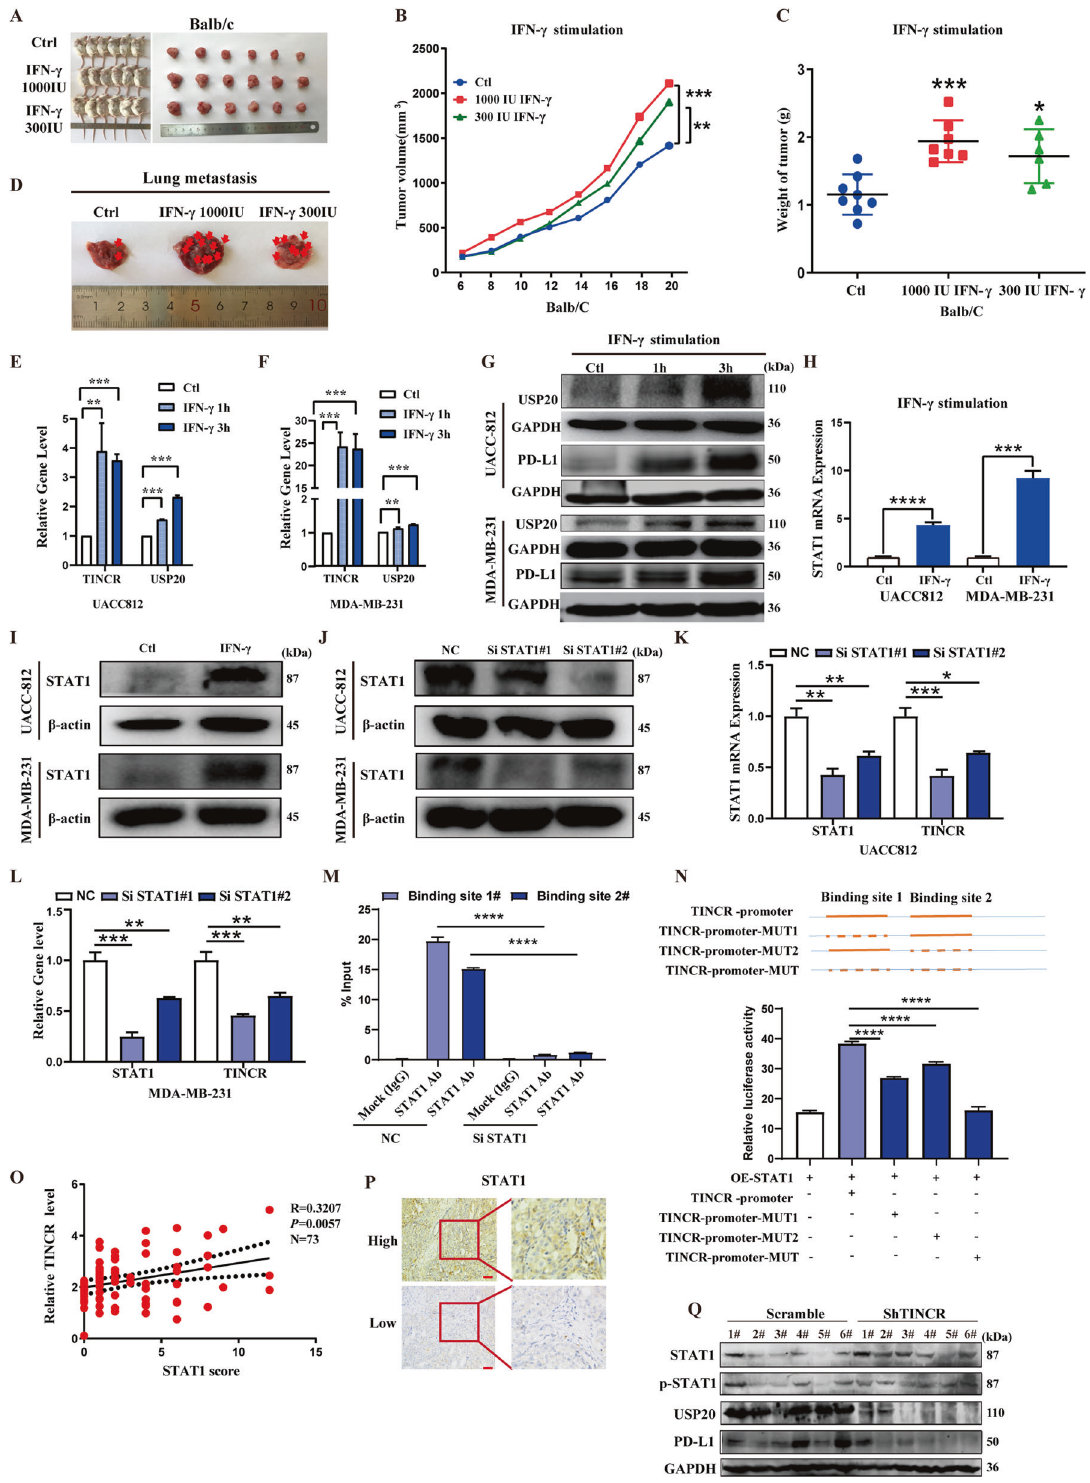
Fig. 6 IFN- γ promotes TINCR expression by upregulating STAT1. A Tumorigenesis and tumor tissues in each group of Balb/c mice ( n = 6/ group). B – D Tumor growth, weight, and number of nodules in the lungs of Balb/c mice per group. E – I Expression of STAT1, TINCR, USP20, and PD-L1, after IFN- γ stimulation. J – L TINCR and STAT1 were detected using qRT-PCR and western after STAT1 knockdown. M , N ChIP and luciferase-reporter assay were used to verify the interaction between TINCR and STAT1. O , P Expression of STAT1 in breast cancer tissues by immunohistochemistry; scale bar, 400 μ m. Q Expression of STAT1, p-STAT1, USP20, and PD-L1 in mouse tissues of the scramble and TINCR knockdown groups ( n = 6/group). Data are presented as means from three independent experiments ± S.D. * P < 0.05, ** P < 0.01, *** P < 0.001, **** P < 0.0001.